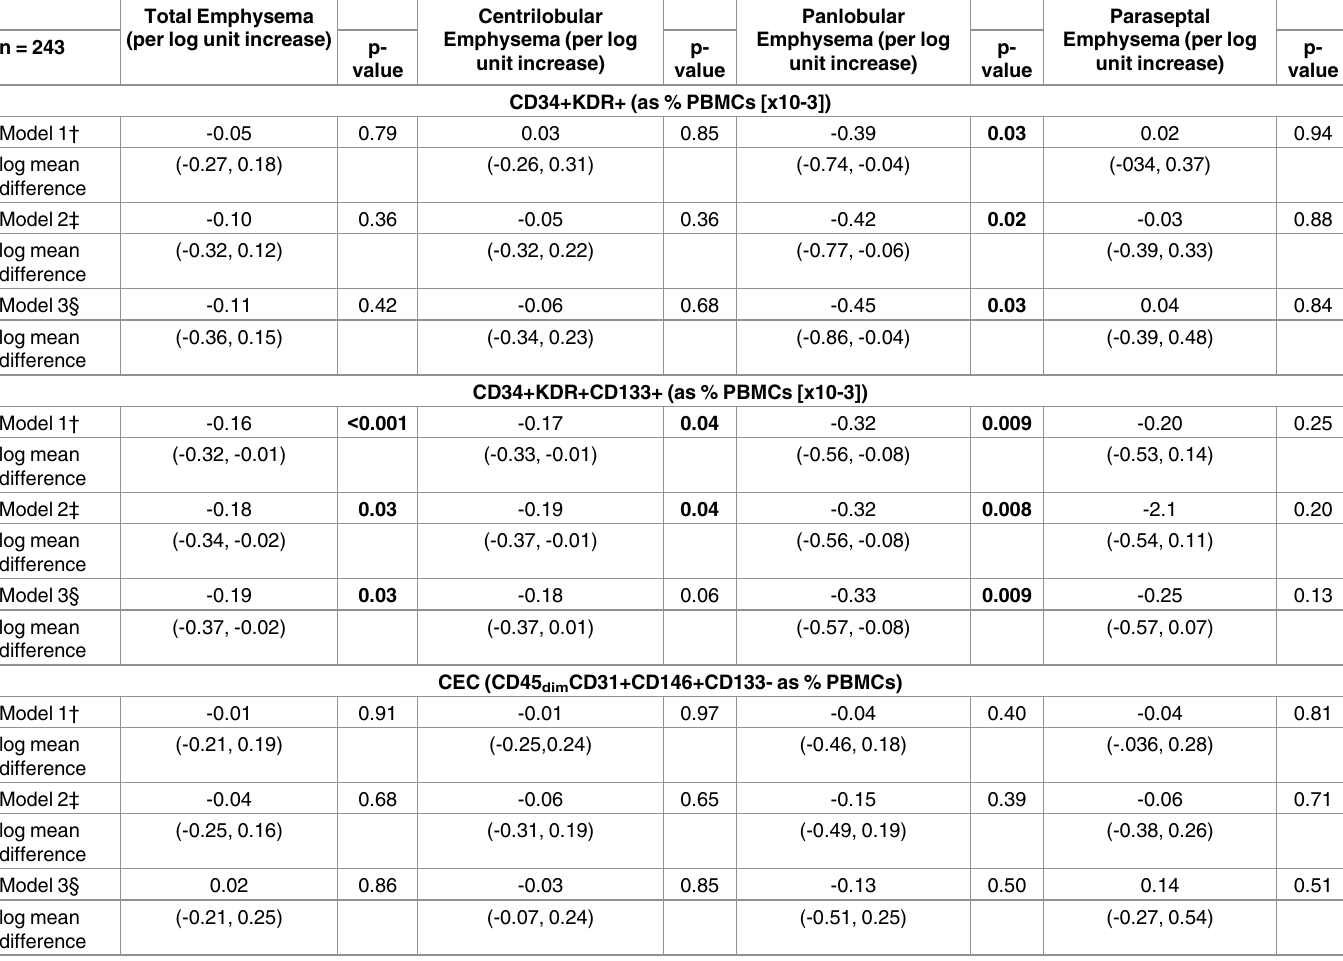
Table 3. Mean differences in endothelial progenitor cells and circulating endothelial cells according to the extent of emphysema and emphysema subtypes on radiologist interpretation. Total Emphysema (per log unit